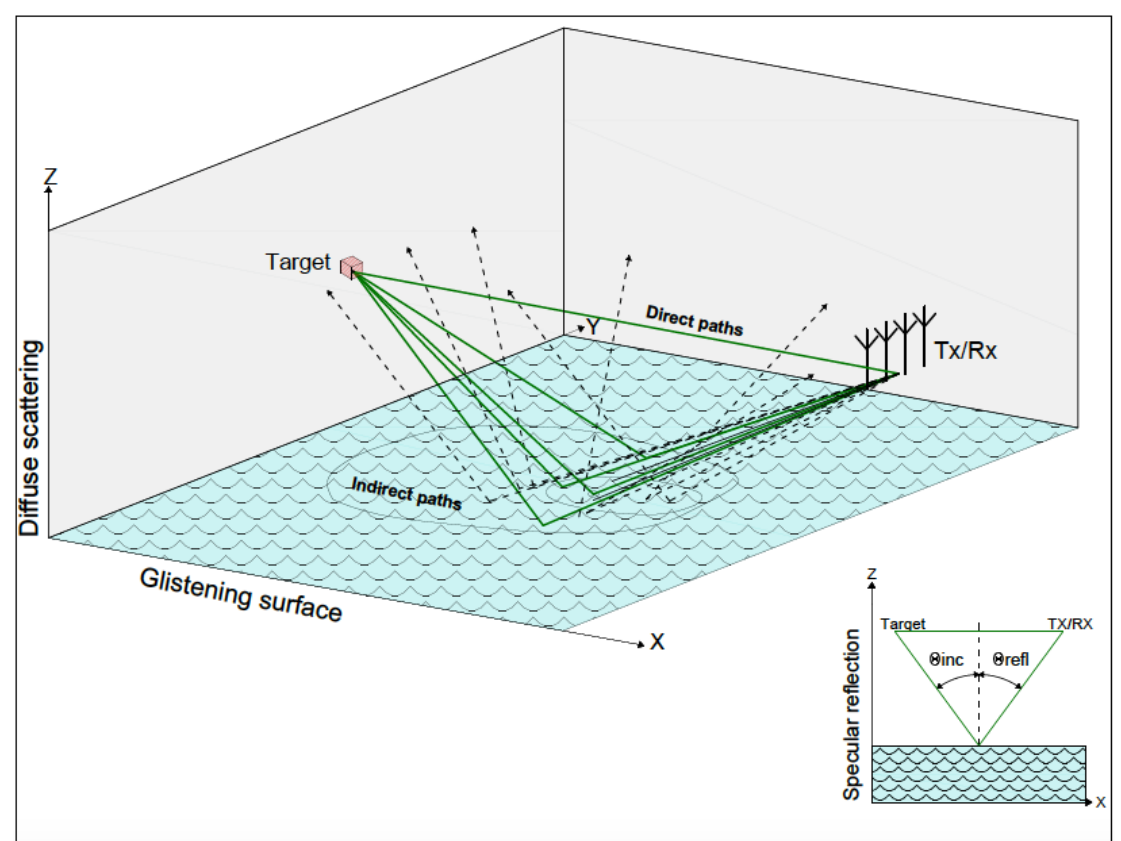
Figure 1. Problem